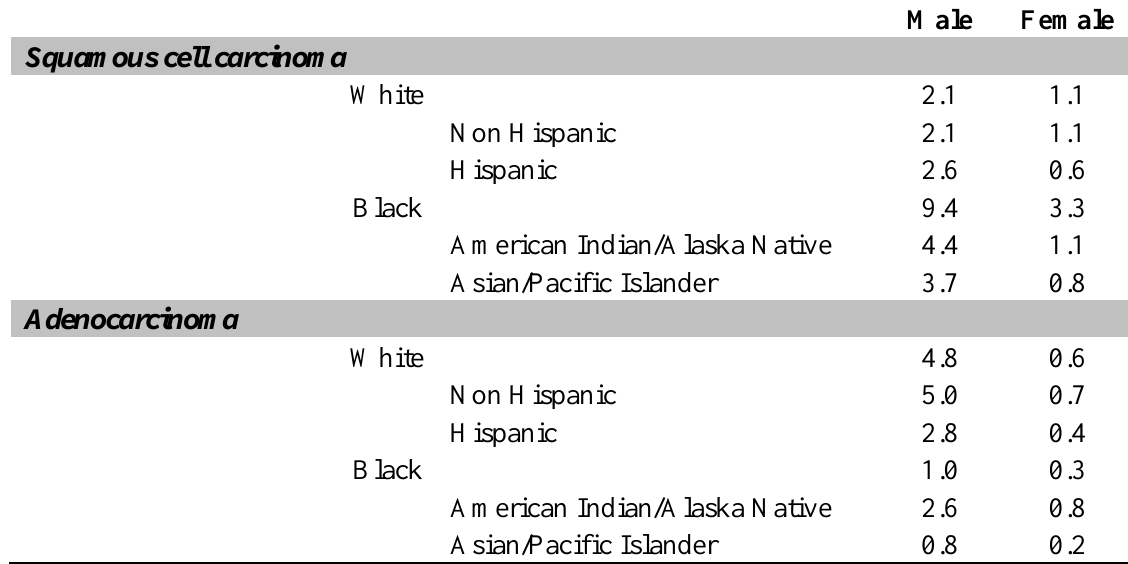
Table 4. US esophageal cancer incidence by histologic type, sex and racial/ethnic group (SEER 13